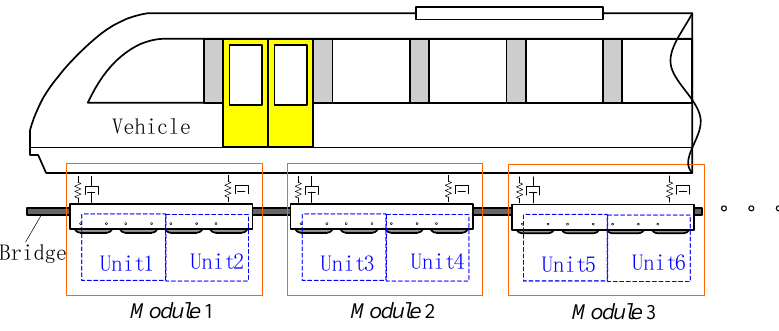
Figure 10. The overall nonlinear dynamic model with ten modules.